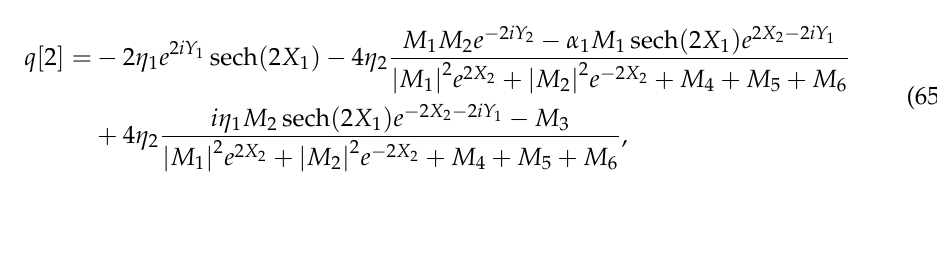
Figure 1. One-soliton solution (64) with α 1 = 0.7, η 1 = 0.6. When N = 2, q [ 0 ] =0 and the spectral parameter λ 2 = α 2 + i η 2 , we obtain a two-soliton solution of Equation